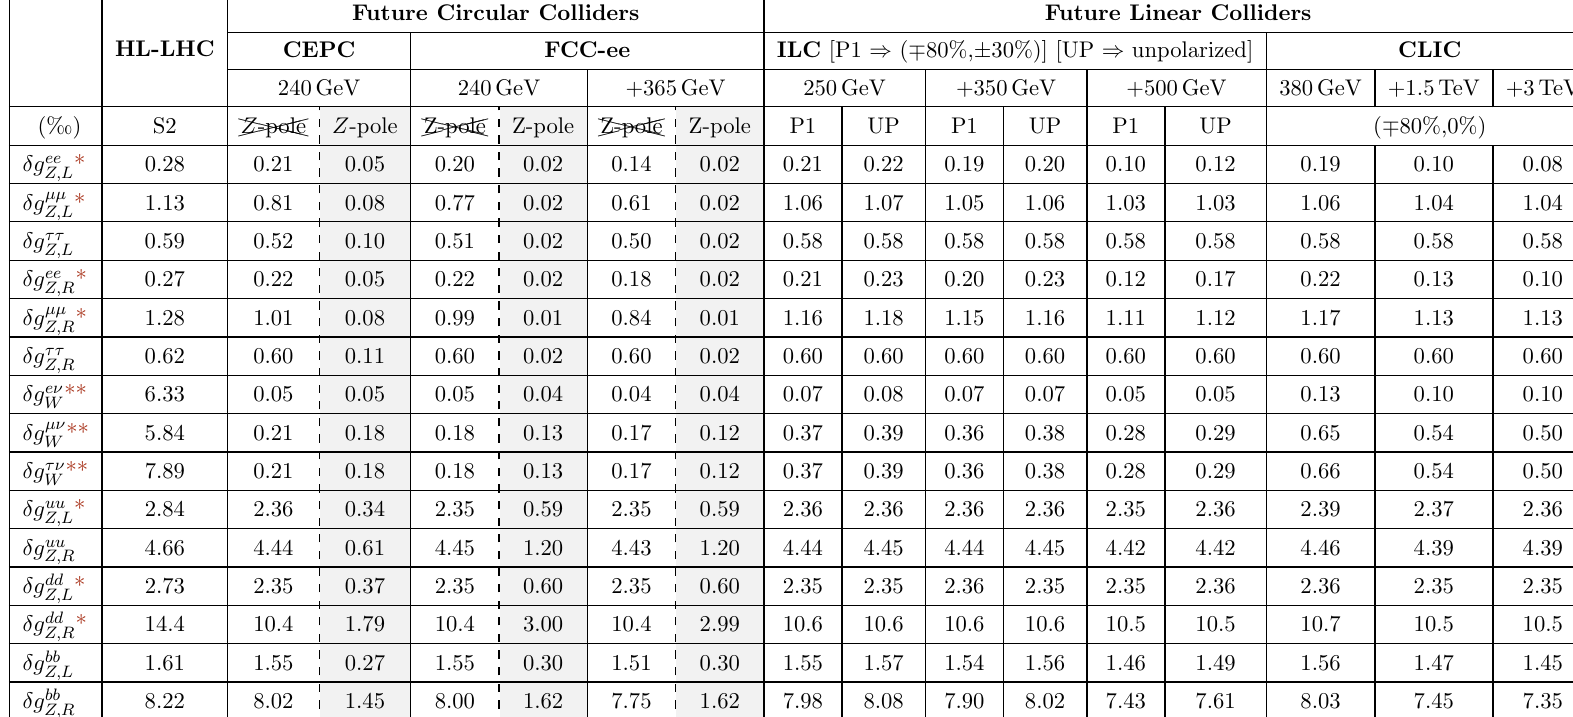
Table 2 . Global one-sigma reach on electroweak couplings, in ‰ . All scenarios include HL-LHC projections as well as LEP and SLC electroweak measurements. With respect to this baseline, the couplings marked with a * see their constraints improved by more than 10% and those marked (cid:24)(cid:24)(cid:24)(cid:24)XXXX with ** by more than an order of magnitude. \ Z -pole" and \ Z -pole" refer to the inclusion of new Z -pole runs at circular colliders. The results are graphically presented in (cid:12)gure